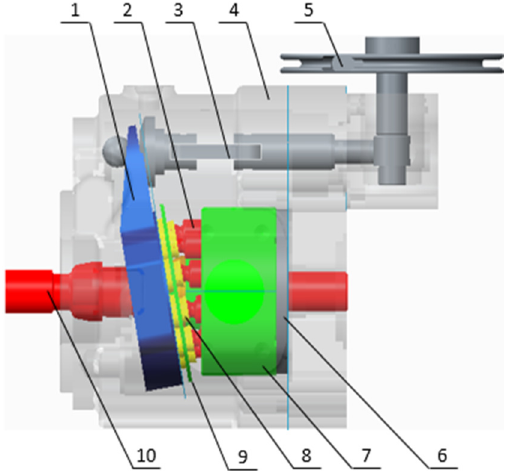
Figure 1. The swash-plate axial piston pump: (1) Swash plate; (2) Pistons; (3) Connecting rod; (4) Shell; (5) Variable displacement mechanism; (6) Valve plate; (7) Cylinder; (8) Slipper; (9) Slipper retainer; (10) Spindle.